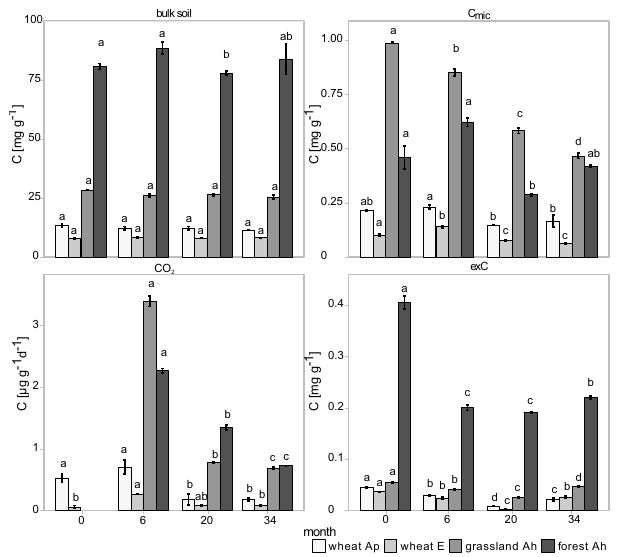
Figure 2. Concentrations of bulk soil C, microbial biomass C (C mic ) , respired CO 2 and K 2 SO 4 -extractable carbon (exC) in wheat Ap and E, grassland Ah and forest Ah before (0) and after 6, 20 and 34months of incubation. Different letters indicate significant differ- ences ( p <0.05) within one treatment over time. Mean and standard error ( n =